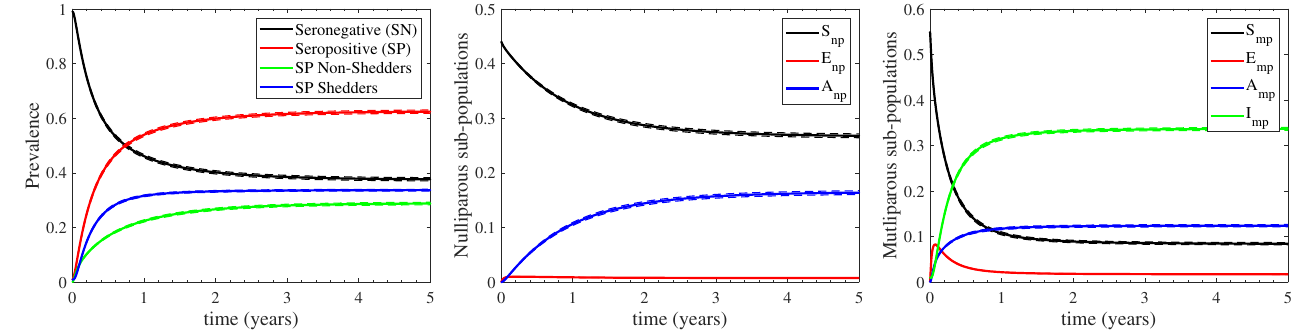
Figure A1. Prevalence ( left panel ) of seronegative (SN) and seropositive (SP) cattle for the continuous housing case, as in the left panel of Figure 3. Nulliparous ( middle panel ) and multiparous ( right panel ) sub-population profiles for the continuous housing case, as in the left panel of Figure 4. The solution profiles are derived on the basis of the 1000 parameter sets considered, with the mean values shown in solid and the 95% confidence intervals in